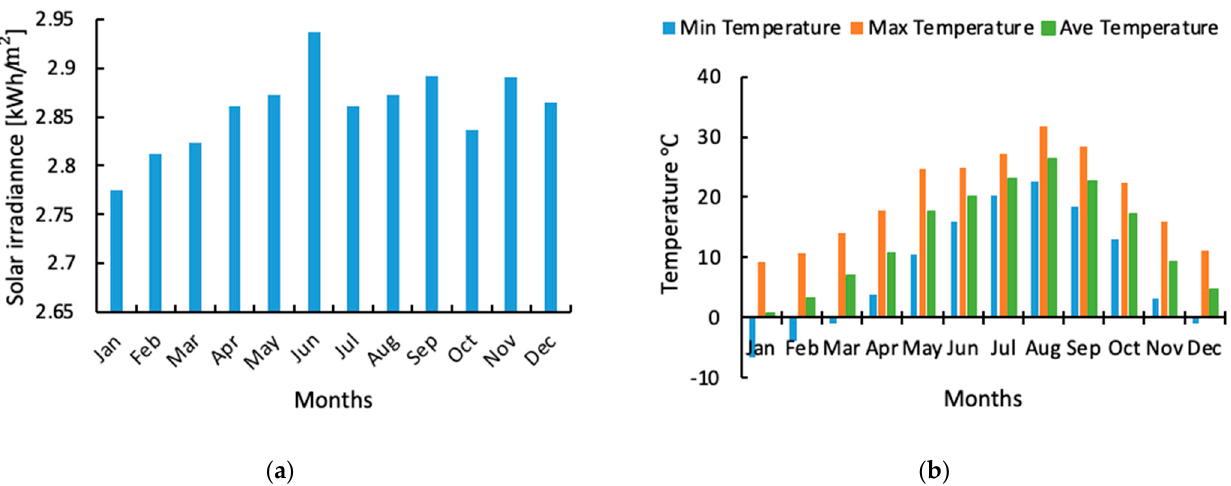
Figure 5. ( a ) Monthly average solar irradiation and ( b ) monthly minimum, maximum, and average temperature [25] of the experiment location.